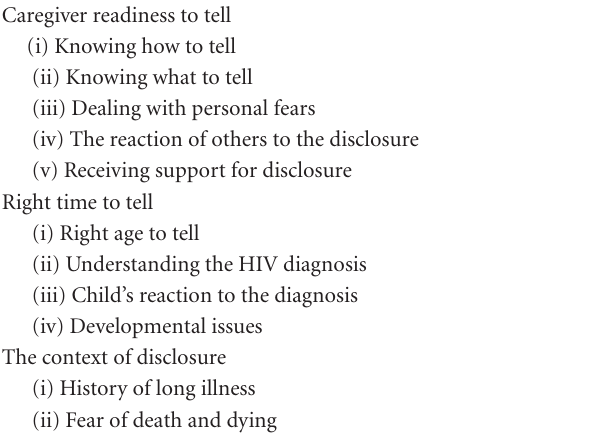
Table 3: Summary of identified